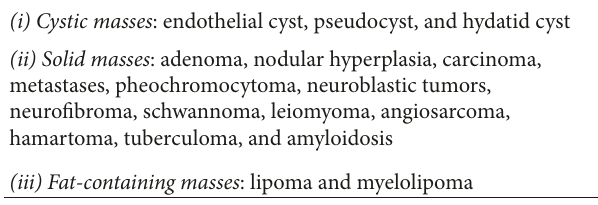
Table 1: Causes of adrenal